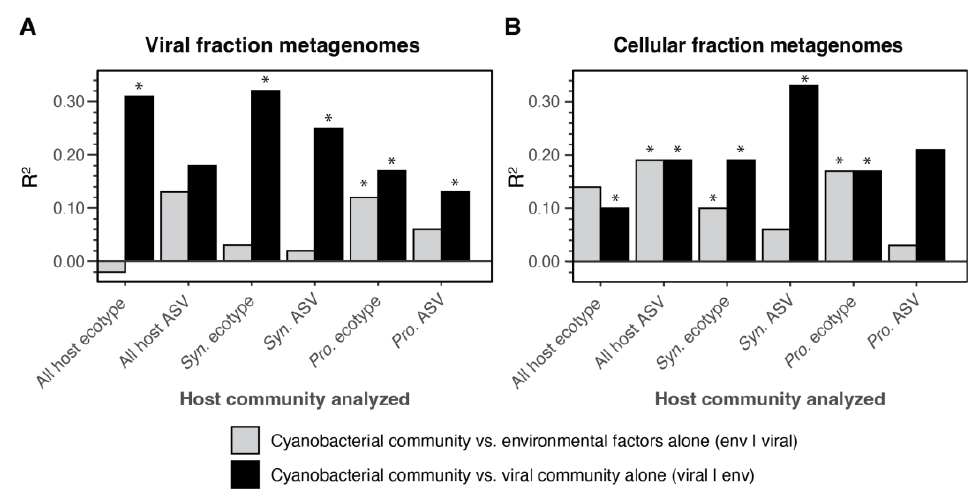
Figure 8. R 2 values from variation partitioning analysis resolving the portion of host community variance explained by environmental variables or viral community structure alone in the ( A ) virome and ( B ) cellular metagenome. Analyses were performed using host community data at various taxonomic levels: all host ASVs together ( Synechococcus and Prochlorococcus ), all host ecotypes together, and ecotypes or ASVs within Synechococcus ( Syn. ) or Prochlorococcus ( Pro. ) separately (see x -axis labels). Asterisks over bars indicate significant ( p < 0.05) R 2 values (Table S4).